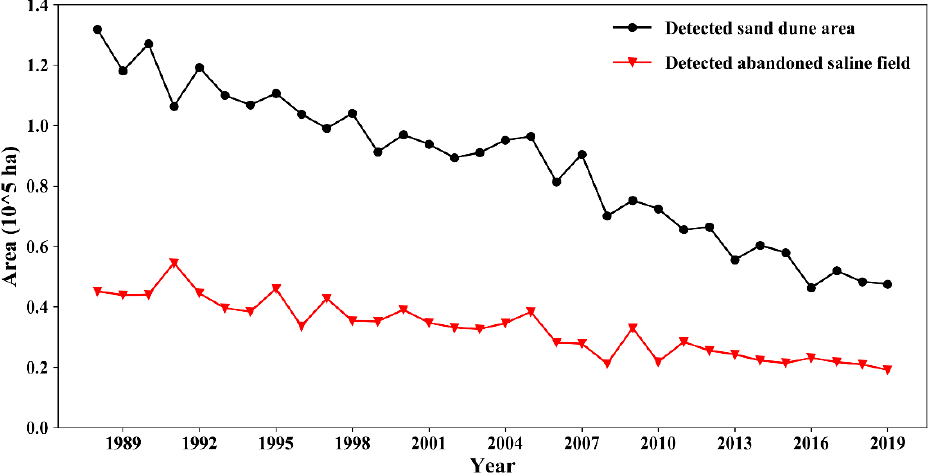
Figure 12. The trend of the area of sand dunes and deserts and the area of abandoned salinized farmland from 1988 to 2019.